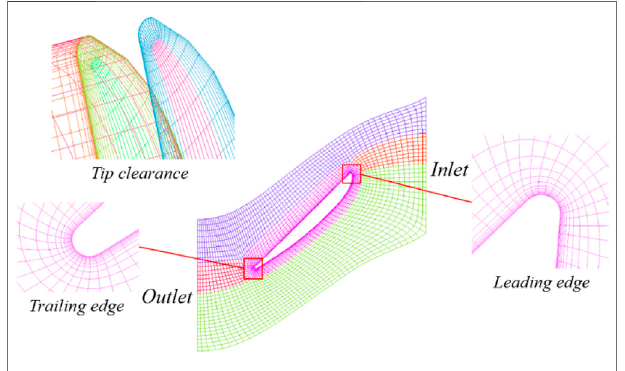
FIGURE 3 | Grid of the blade runner.